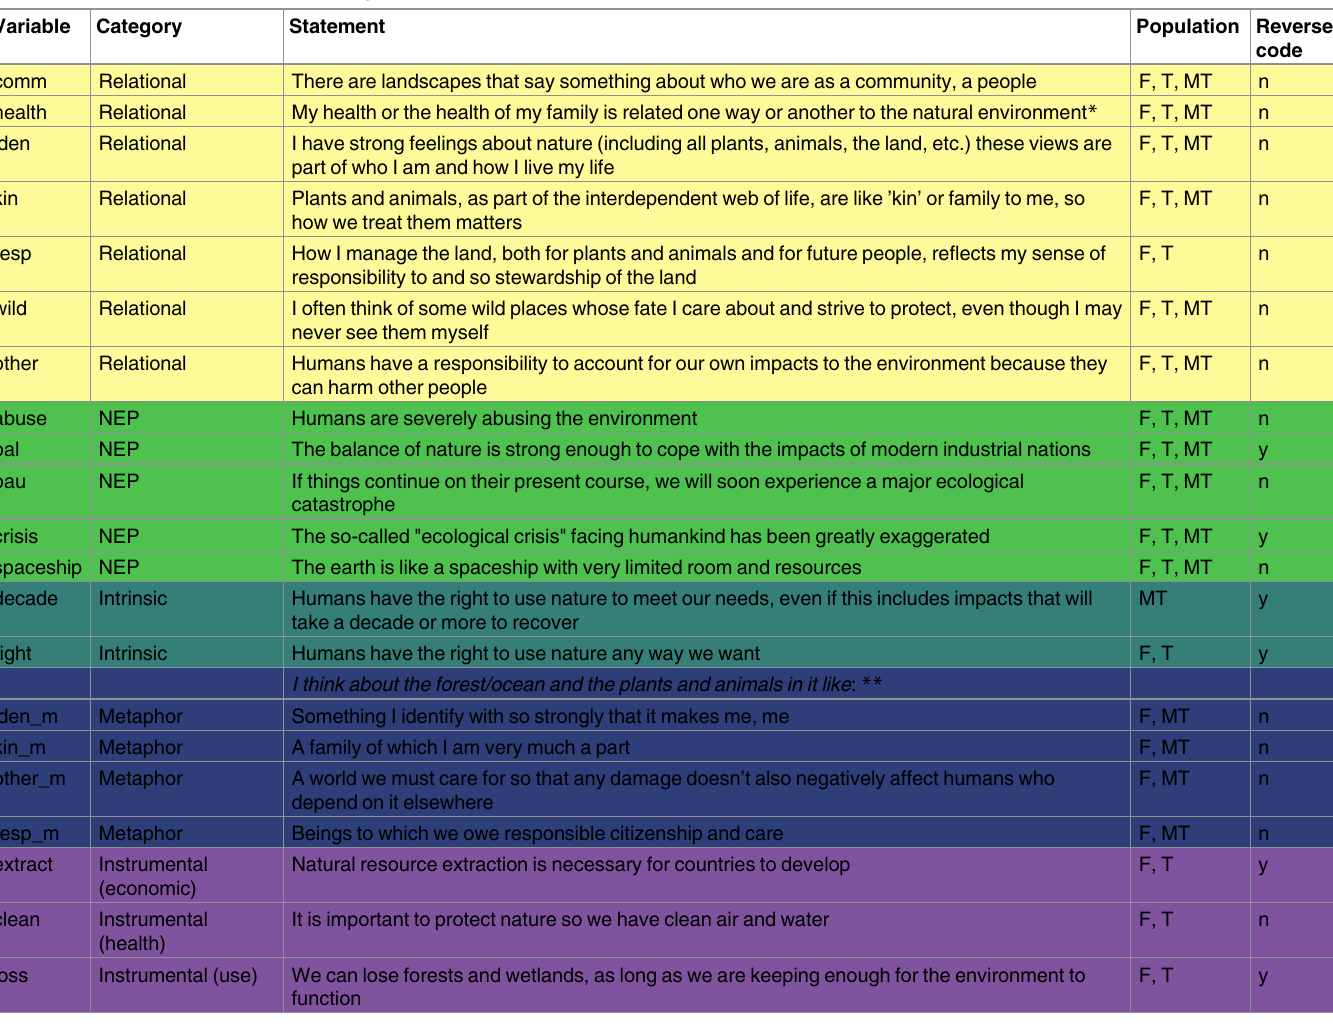
Table 1. Value statements used in